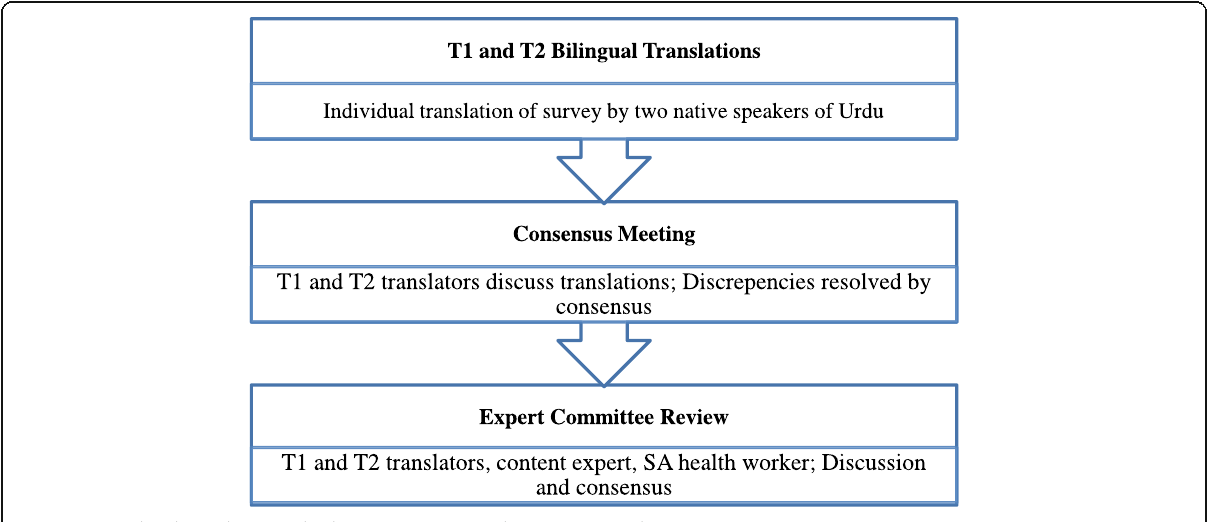
Fig. 1 Cross cultural Translation and Adaptation. Beaton et al. [8]; Epstein et al.